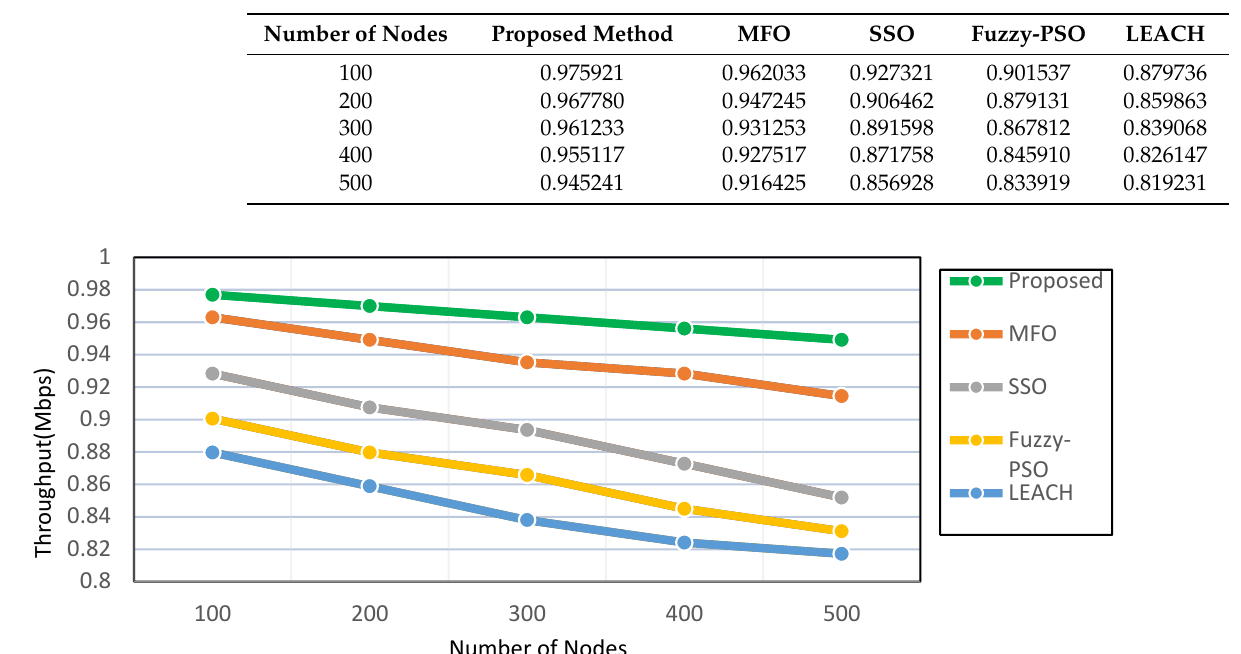
Figure 4. Analysis of throughput vs. number of nodes. Table 5. End-to-end delay comparison with different routing protocols.